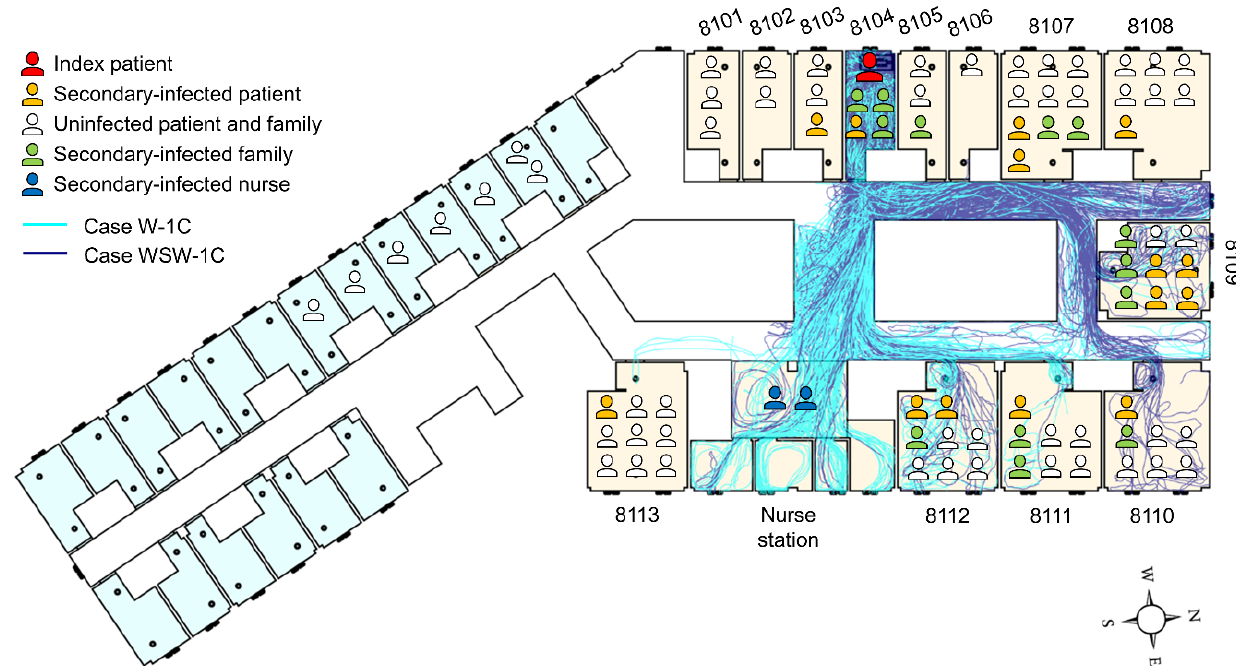
Figure 8. Schematic of MERS patients on the 8th floor of Pyeongtaek St. Mary’s Hospital with the trajectories of cough particles. Maternity ward and general ward are colored light blue and light brown, respectively.